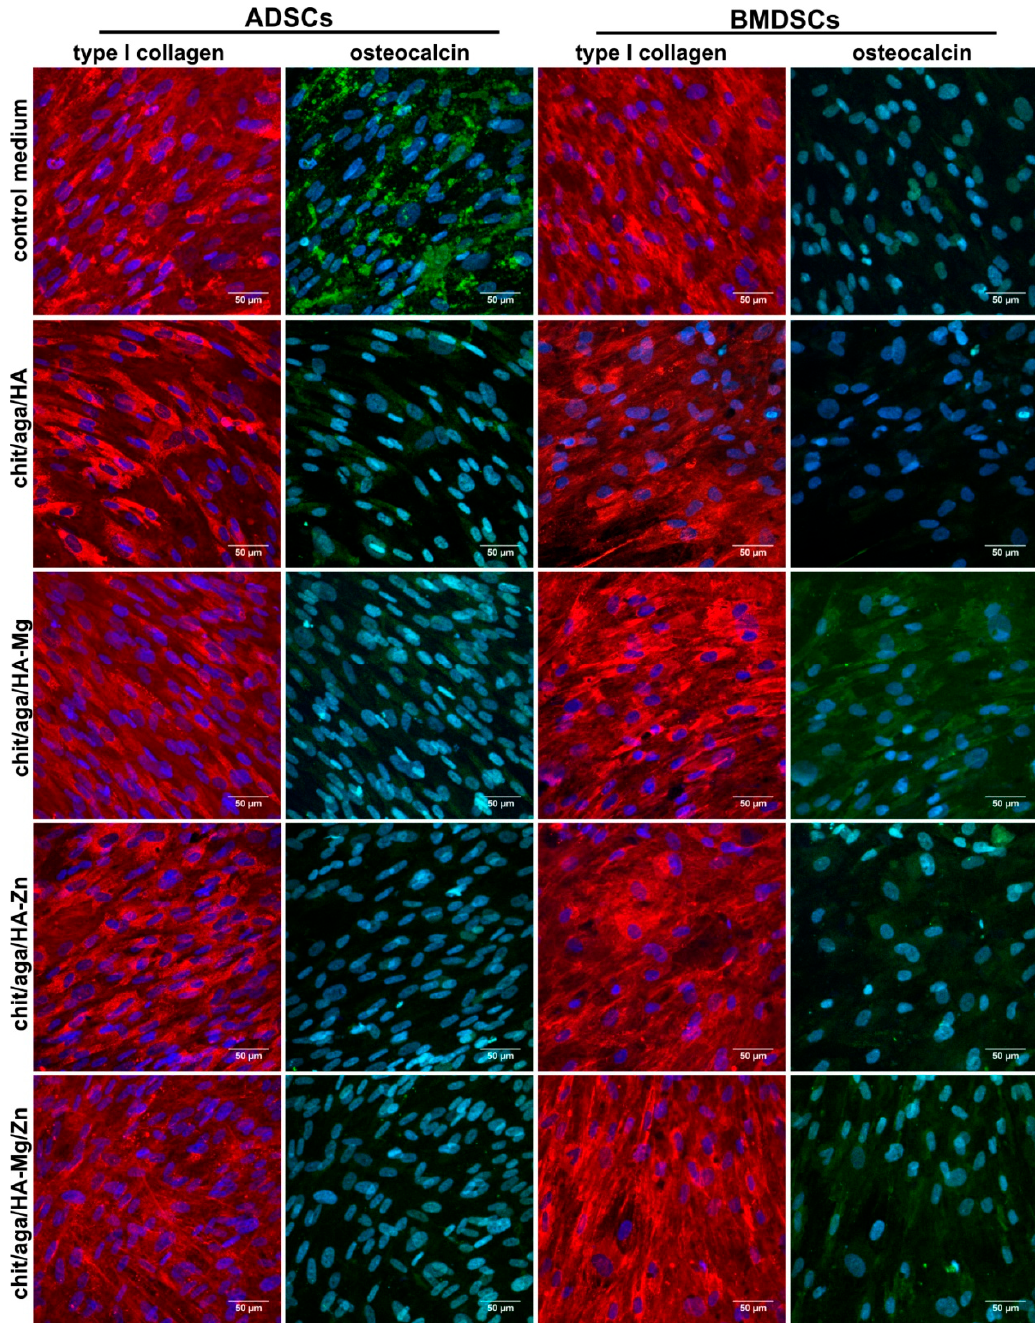
Figure 8. CLSM images presenting immunofluorescent (IF) staining of type I collagen and osteocalcin in the extracellular matrix (ECM) of MSCs cultured in PS wells in the presence of scaffolds extracts (control medium, cells maintained in osteogenic medium); collagen, red fluorescence; osteocalcin, green fluorescence; and nuclei, blue fluorescence, magnified 400×; scale bar = 50 µm.